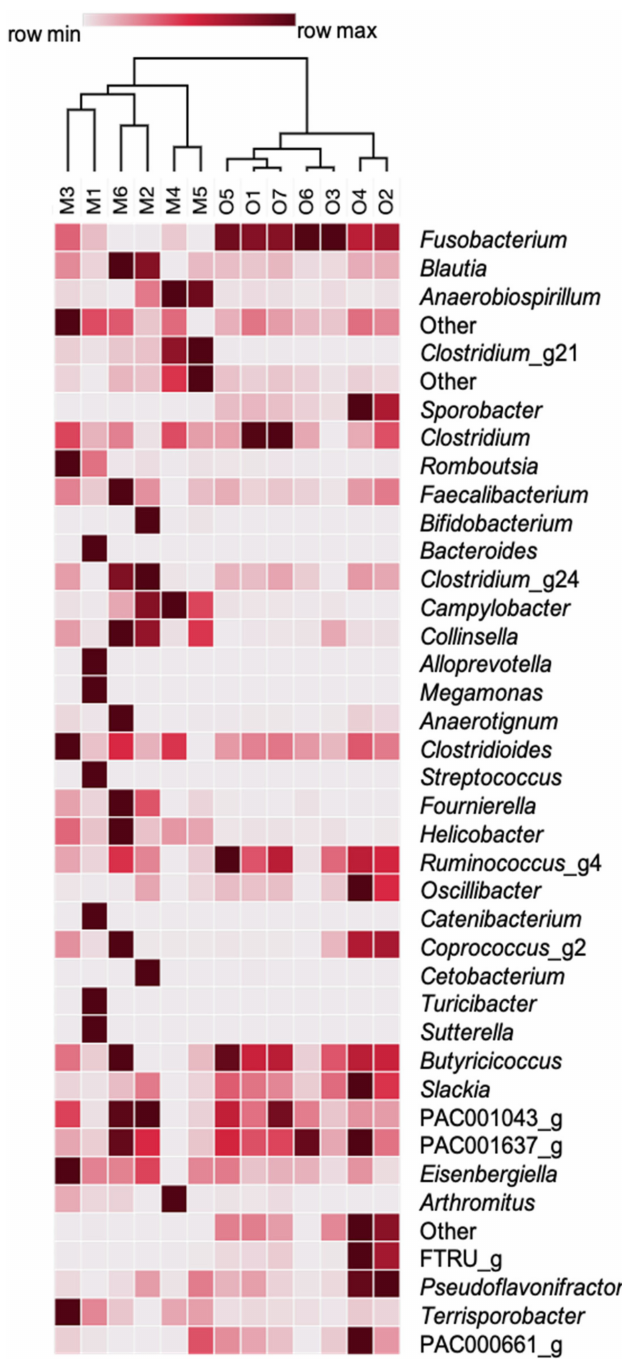
Figure 5. Heatmap of the fecal bacterial taxa (genera level) from two populations of Mexican wolves ( Canis lupus baileyi ) in Michilia (M, 23 ◦ N) and Ocotal (O, 19 ◦ N), Mexico; only the first 40 more abundant genera are